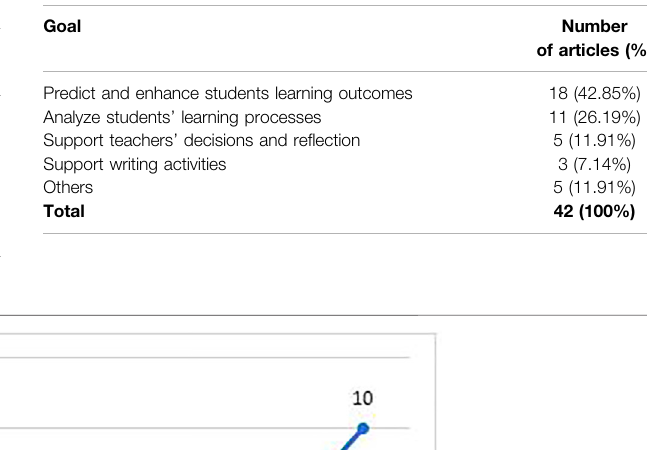
TABLE 7 | Main educational goals in using learning analytics in high schools